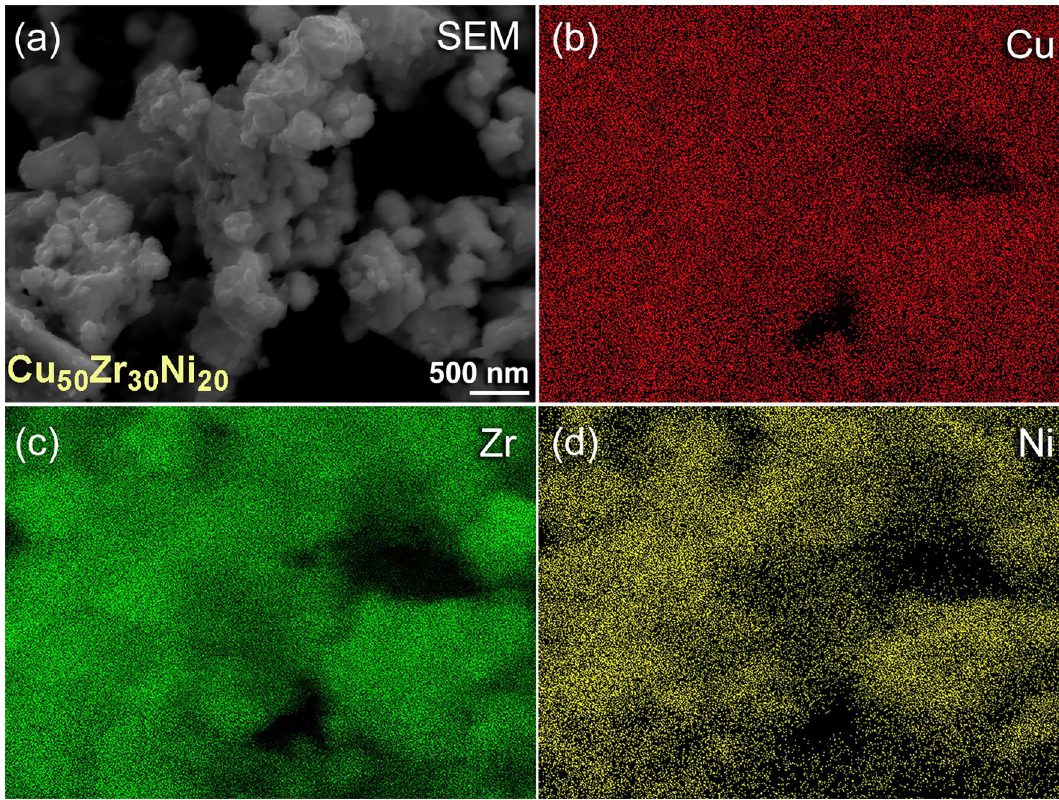
Figure 5. Morphological and local elemental distributions conducted by FE-SEM/energy dispersive X-ray spectroscopy (EDS) for MG Cu 50 Zr 30 Ni 20 powders obtained after 50 of MA time. ( a ) SEM, and X-ray EDS mapping of ( b ) Cu-K α , ( c ) Zr-L α , and ( d ) Ni-K α